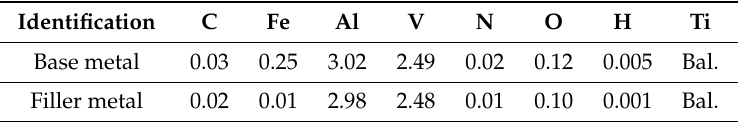
Table 2. Welding and TIG dressing parameters.